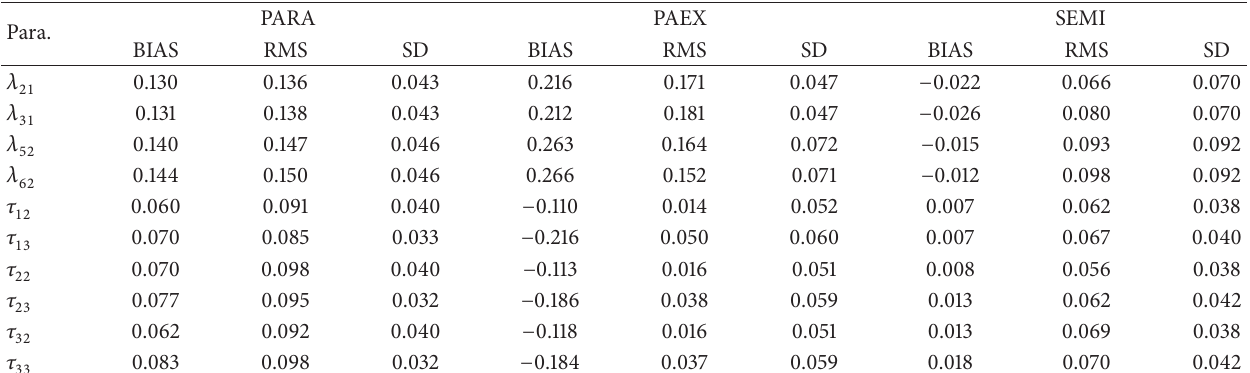
Table 1: Summary of the estimates under the parametric, partly exchangeable, and semiparametric approaches in analyzing simulated data: mixture data.